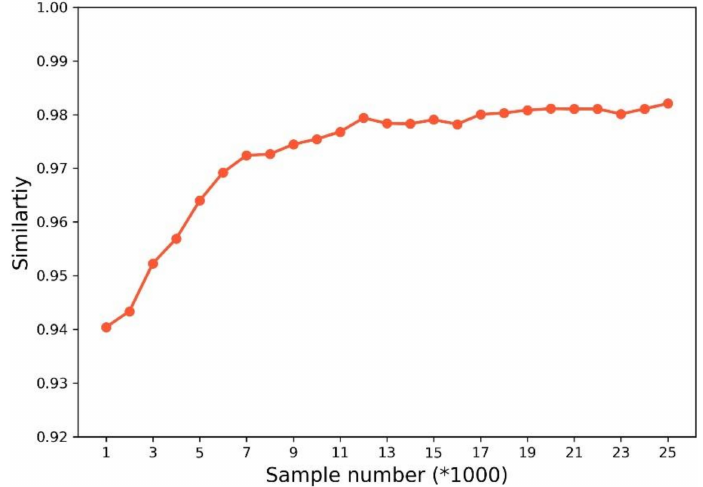
Figure 11. The relationship between similarity and input images with di ff erent sampling numbers. When calculating the similarity index using a cosine similarity method, the resolution of an input image can be changed. The maximum input image resolution is 200 × 200 in the initial image, while